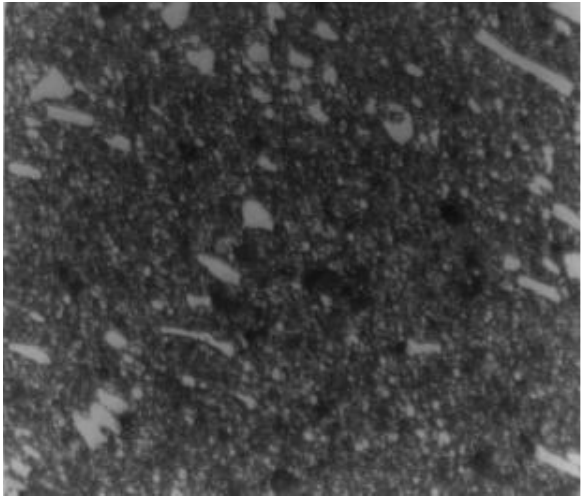
Figura 11. Ensaio 1; Z w = 1200 mm 3 /mm.